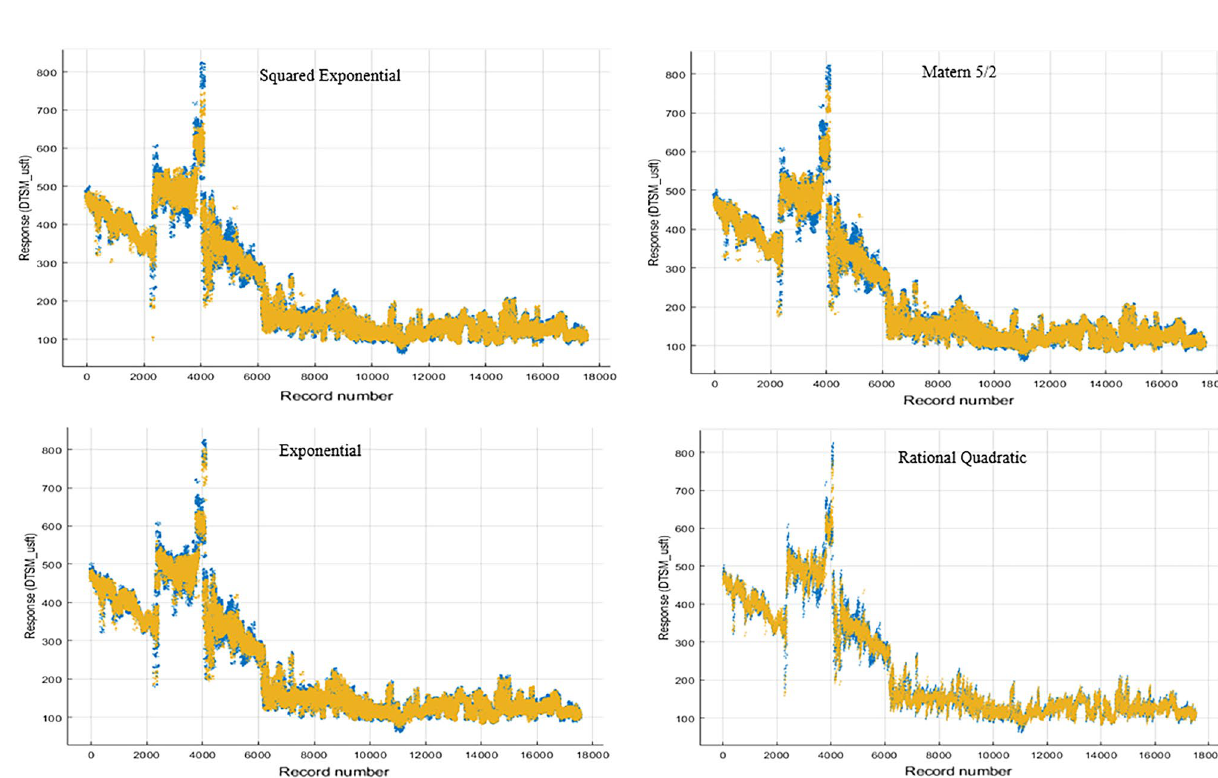
Fig. 4 The response of the tested GP models (actual in blue and predicted in